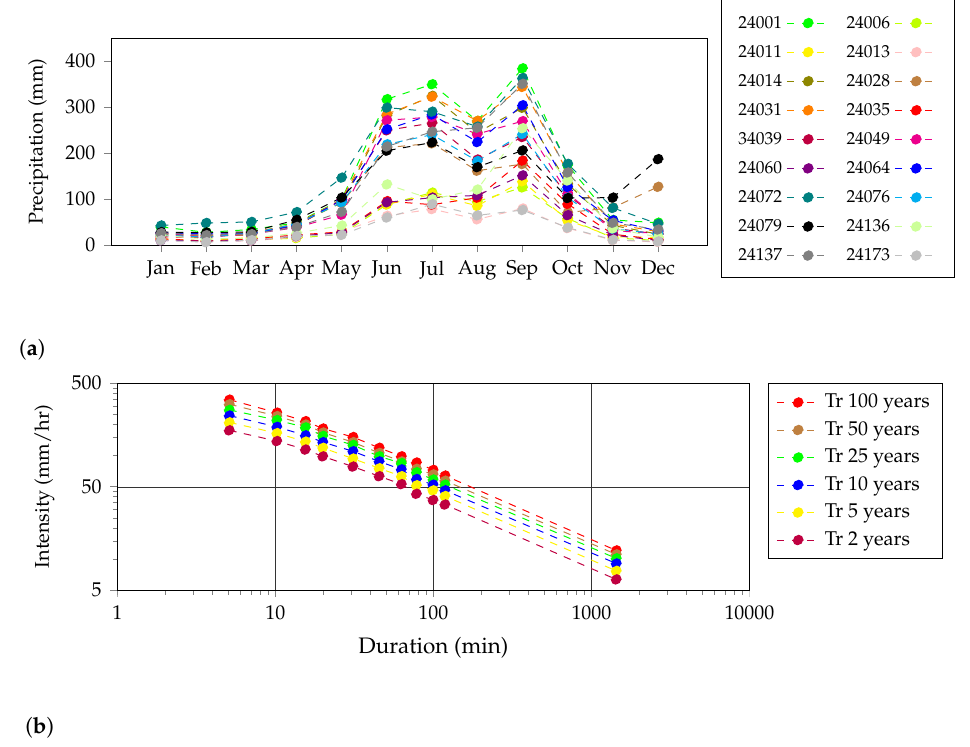
Figure 2. Precipitation of the watershed of the study zone. ( a ) Average monthly precipitation values for the time period under study. ( b ) Intensity-Duration-Return Period curves (I-D-Tr). Table 2. Precipitation Values (P) for different Return Periods